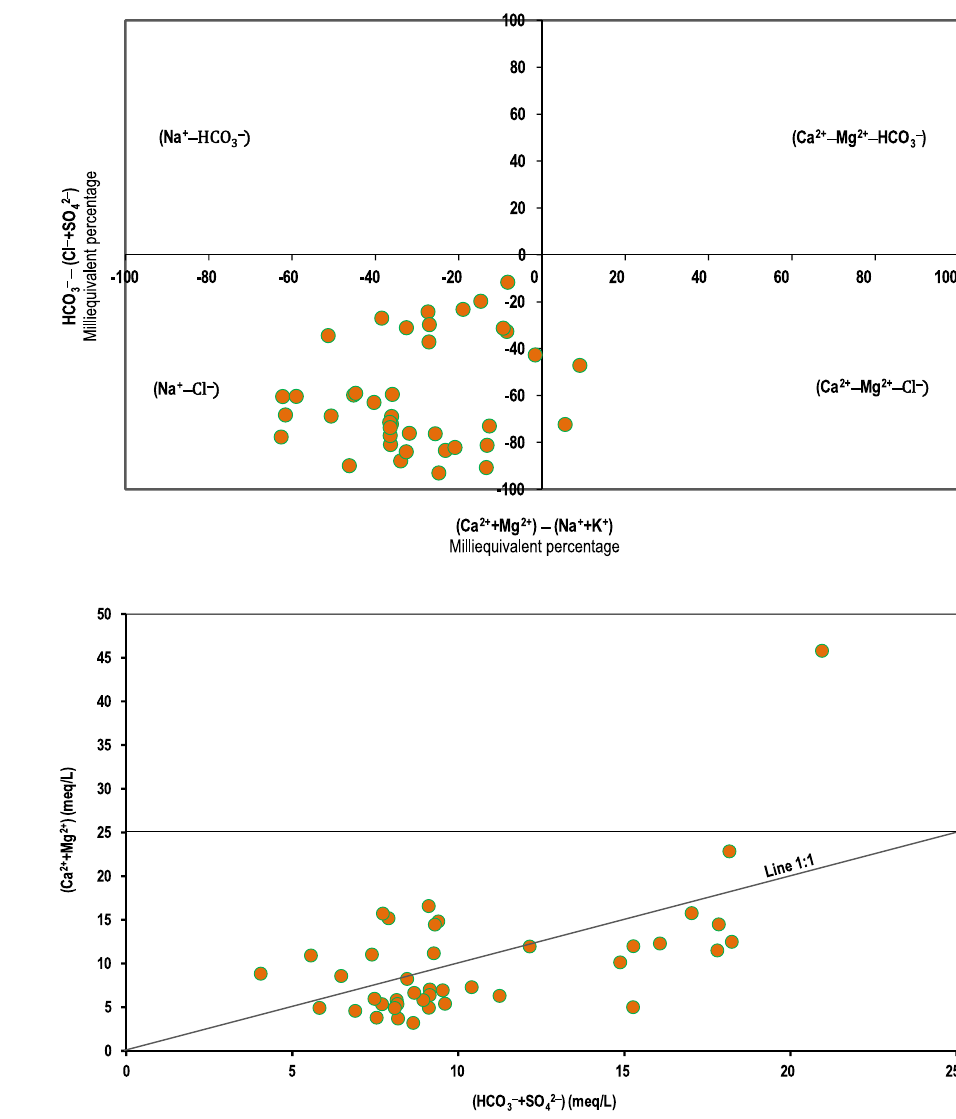
Fig. 6 Plot of (HCO 3– + SO 42– ) versus (Ca 2+ + Mg 2+ ) in groundwater samples from the study